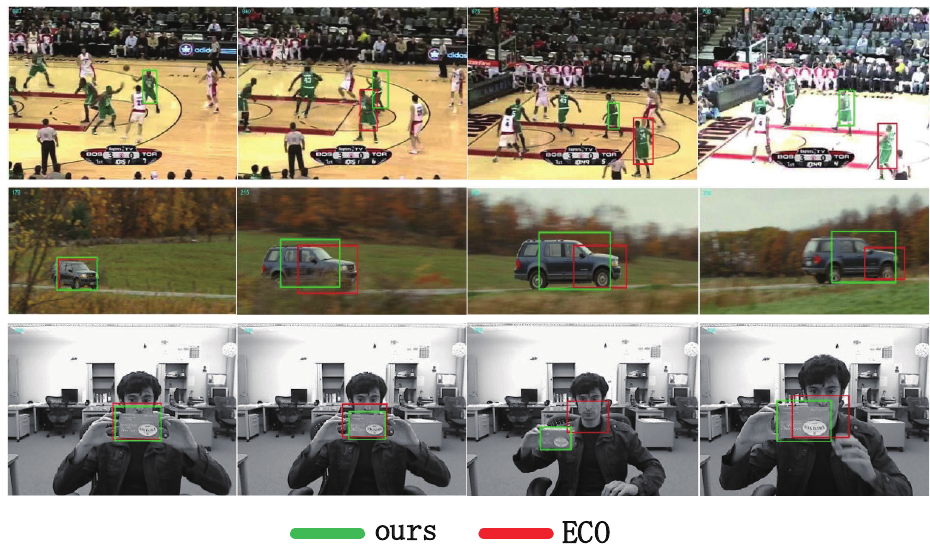
Figure 1. Our approach is compared with the ECO [1] on three test sequences called Basketball ( top row ), CarScale ( middle row ), and Twinnings ( bottom row ). ECO (red box) does not consider the reliability of the tracking result and is easily affected by similar objects, scale variability, and rotation. Our approach (green box) evaluates the result’s reliability by AES.